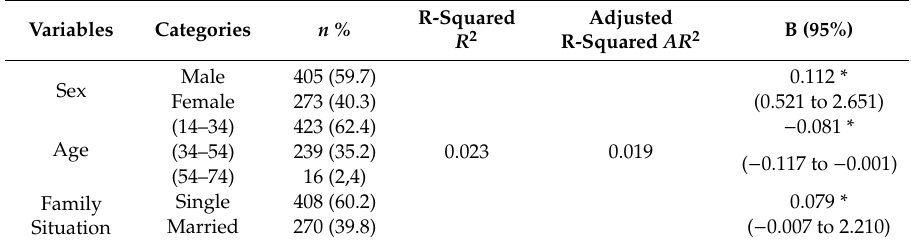
Table 6. Association between demographic variables and the psychological impact of the coronavirus COVID-19 in Algeria during the first containment of the epidemic ( n = 678).